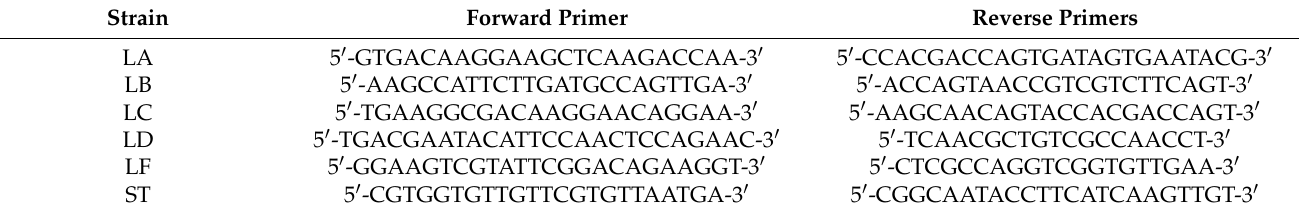
Table 5. Specific primers for six strains of lactic acid bacteria (LAB).